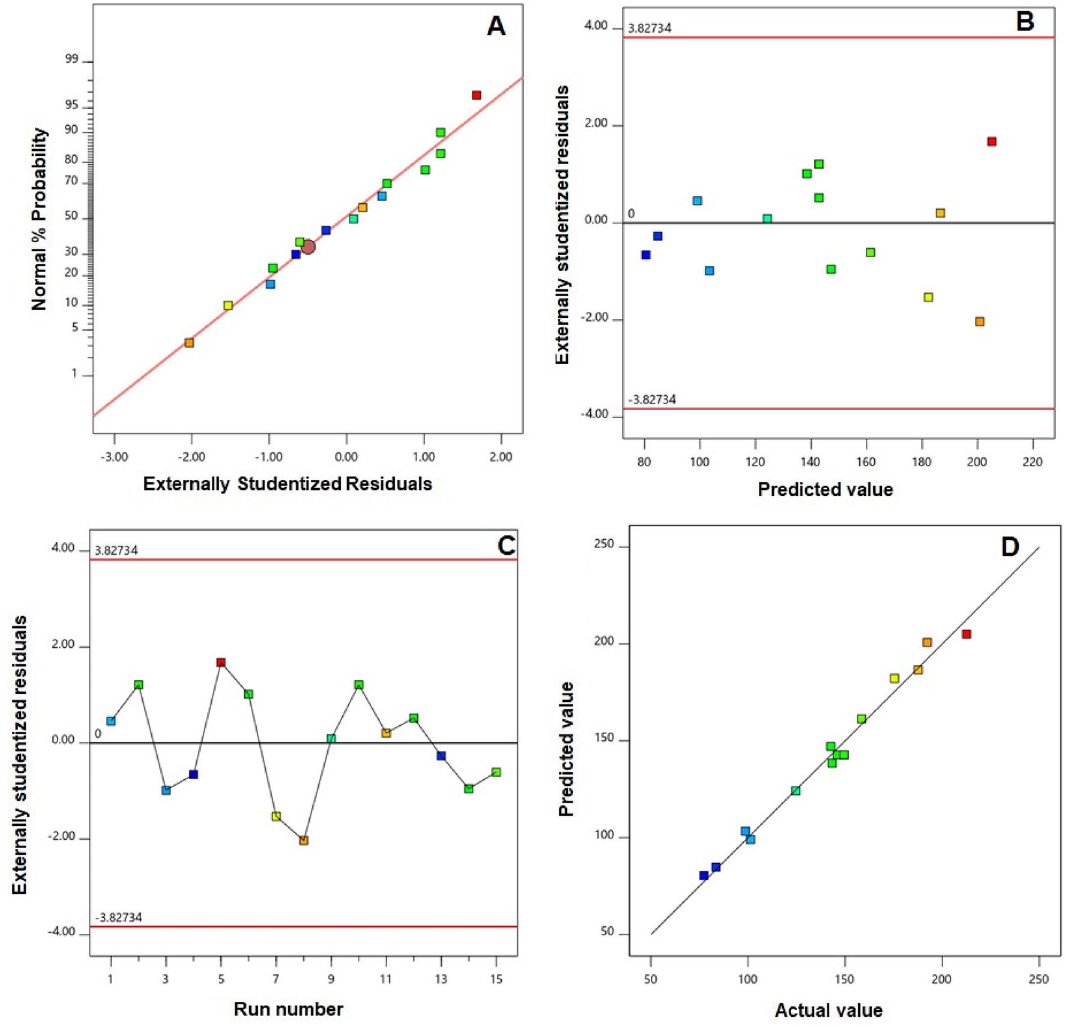
Figure 1. Diagnostic plots for FLV-PL-ALA-MEL nanoparticles size. ( A ) Normal probability plot ( B ) studentized residuals vs. predicted values plot ( C ) externally studentized residuals vs. run number plot and ( D ) predicted vs. actual values